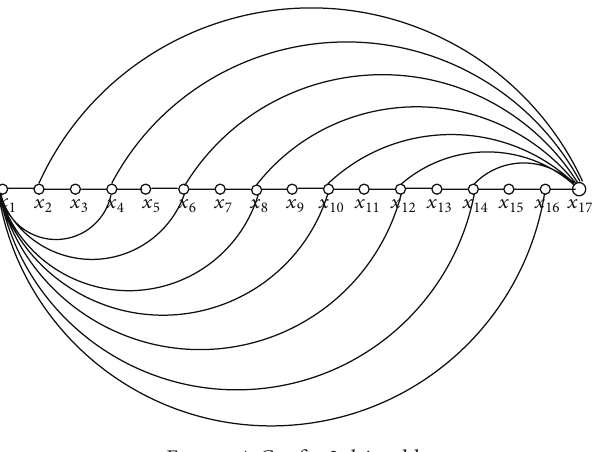
Figure 4: Config-2: 𝑘 is